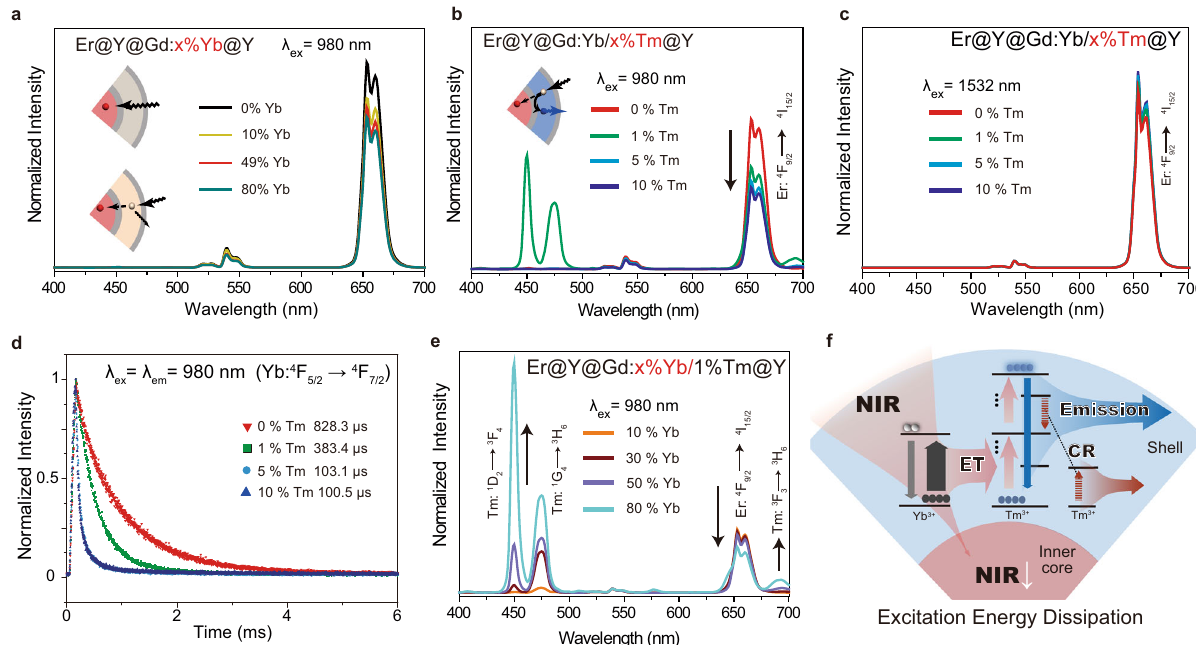
Fig. 3 Investigation of energy dissipation based process. a Emission spectra in the red channel of NaErF 4 @NaYF 4 @NaGdF 4 :x%Yb@NaYF 4 UCNPs (x = 0, 10, 49, 80) with different shell composition. b , c Emissions spectra of NaErF 4 @NaYF 4 @NaGdF 4 :49%Yb/y%Tm@NaYF 4 UCNPs (y = 0, 1, 5, 10). d Luminescence decay curves at 980nm of the obtained UCNPs with different Tm 3 + doping ratios under 980nm excitation. λ em emission wavelength. e Emissions spectra of NaErF 4 @NaYF 4 @NaGdF 4 :x%Yb/1%Tm@NaYF 4 UCNPs (x = 10, 30, 50, 80). All of the UCNPs samples in these tests were dispersed in cyclohexane for the collection of spectra. Shell thickness is tuned around ~4nm. λ ex excitation wavelength. Power density is set at 45mW/mm 2 . f Diagrams illustrating the energy dissipation dominating process. Suppression of the inner core ’ s emission is substantially dominated by excitation energy dissipation, which can be enhanced through increasing energy transfer (ET) and subsequent energy consumption from emission or cross-relaxation (CR). Source data are provided as a Source Data fi